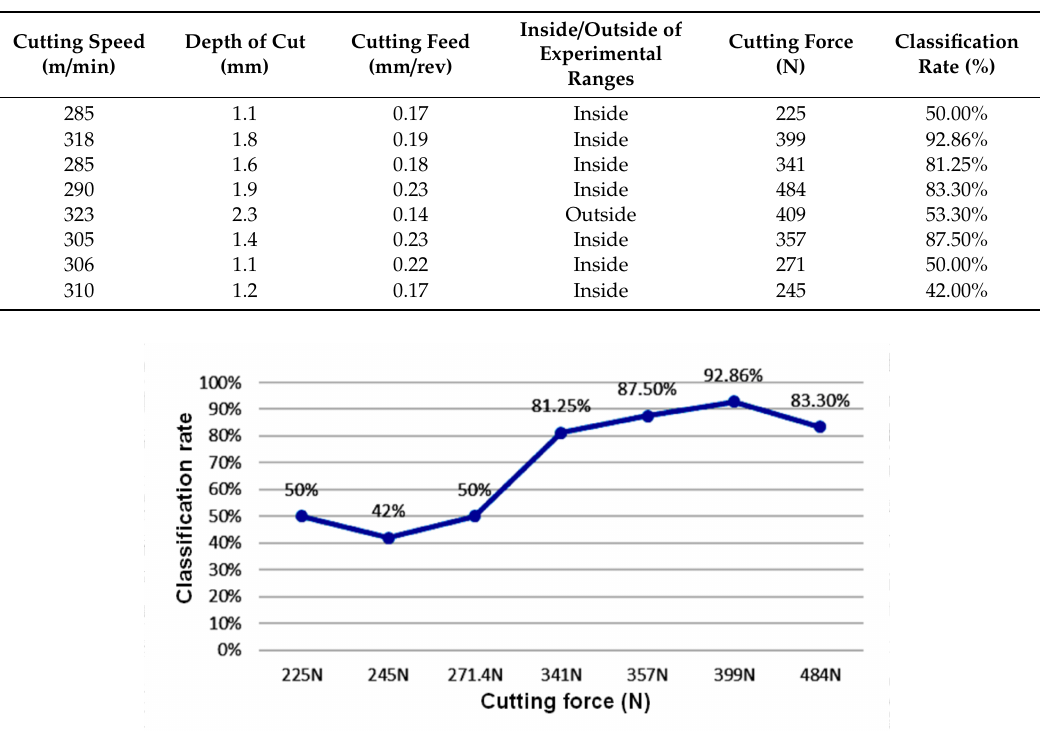
Table 11. Experimental results comparison table.